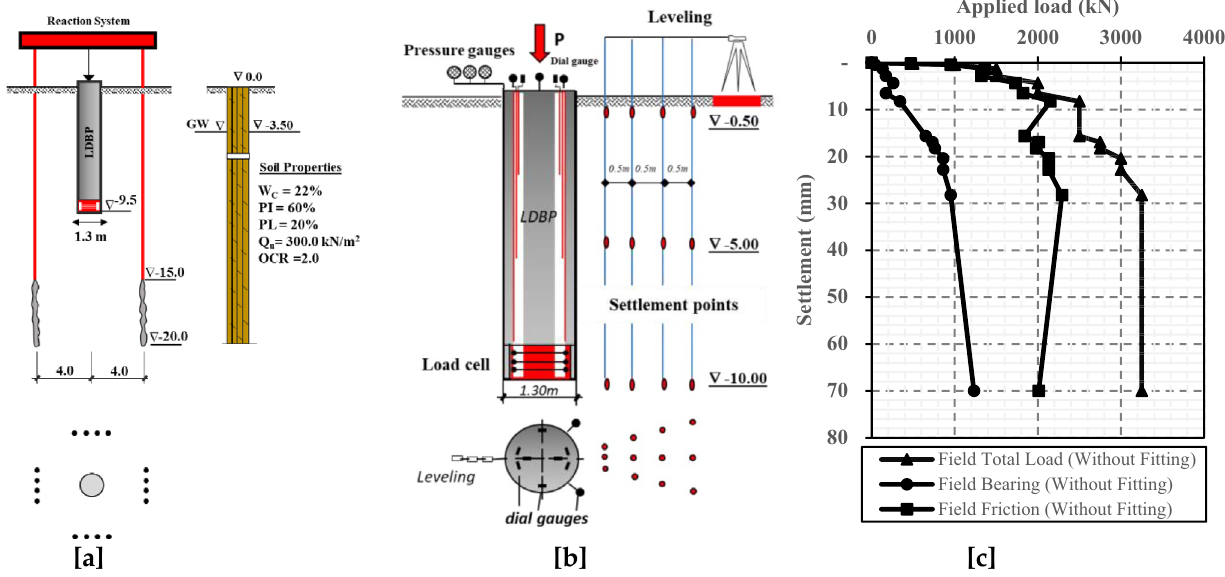
Figure 1. Large diameter bored pile loading to failure test (Modified from Sommer and Hammbach 36 ). ( a )